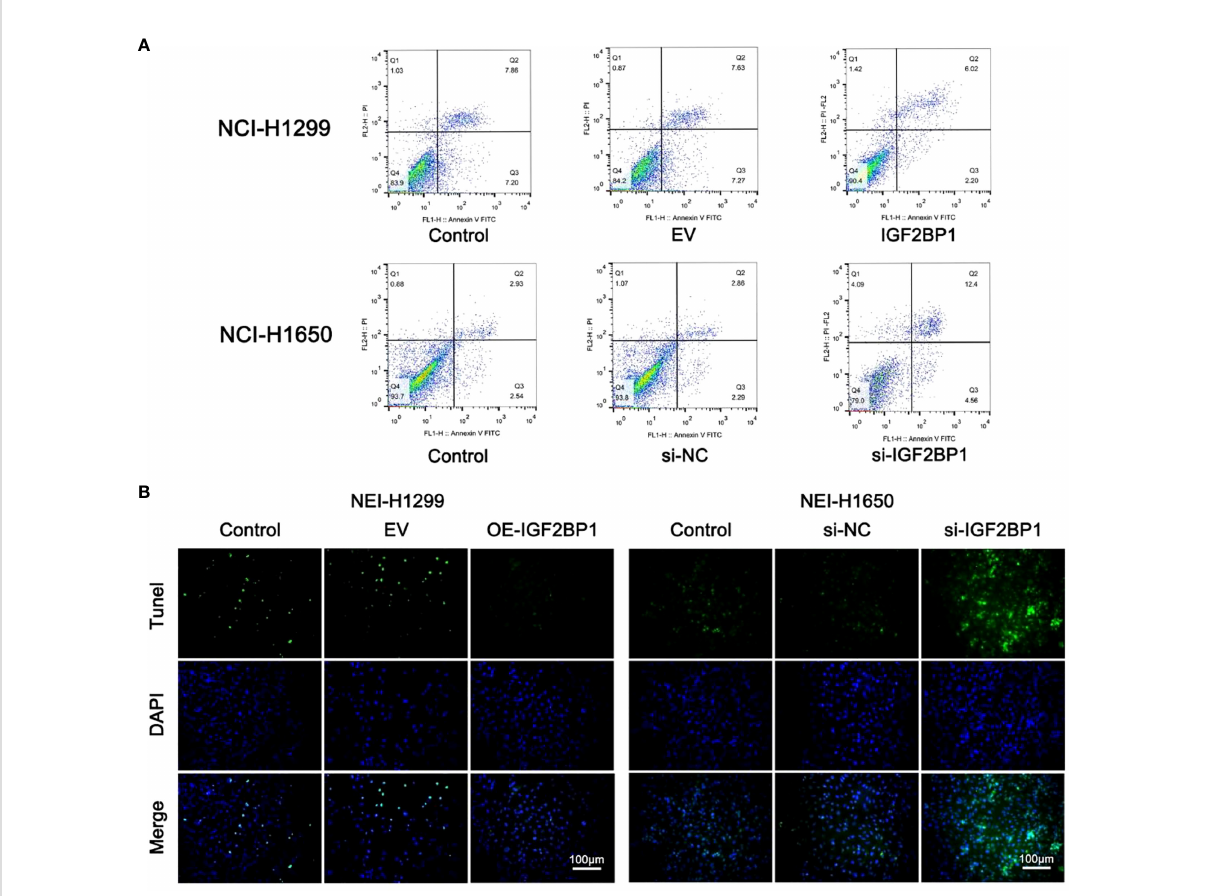
FIGURE 7 IGF2BP1 promoted the proliferation and invasion of LUAD cell lines. (A) Annexin V-FITC/PI assay was used for accessing the migration of each treatment group of NCI-H1299 cells and NCI-H1650 cells. (B) TUNEL assay was used for accessing the invasion of each treatment group of NCI-H1299 cells and NCI-H1650 cells. EV, empty vector group. IGF2BP1, IGF2BP1-overexpressed group. si-NC, negative control siRNA group. si-IGF2BP1, IGF2BP1 knocked-down